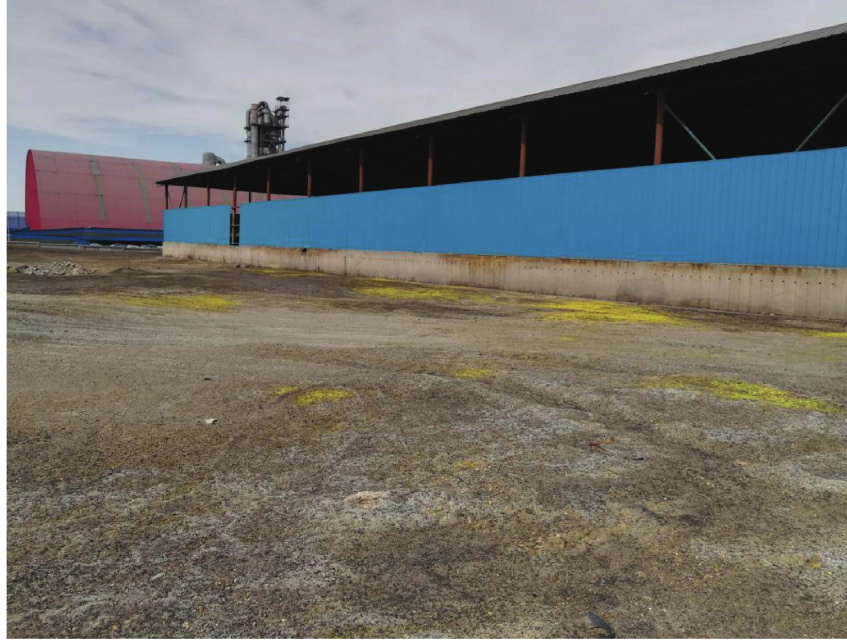
Figure 1: Picture of chromium contaminated Table 1: Physicochemical properties of Cr(VI) contaminated soil.